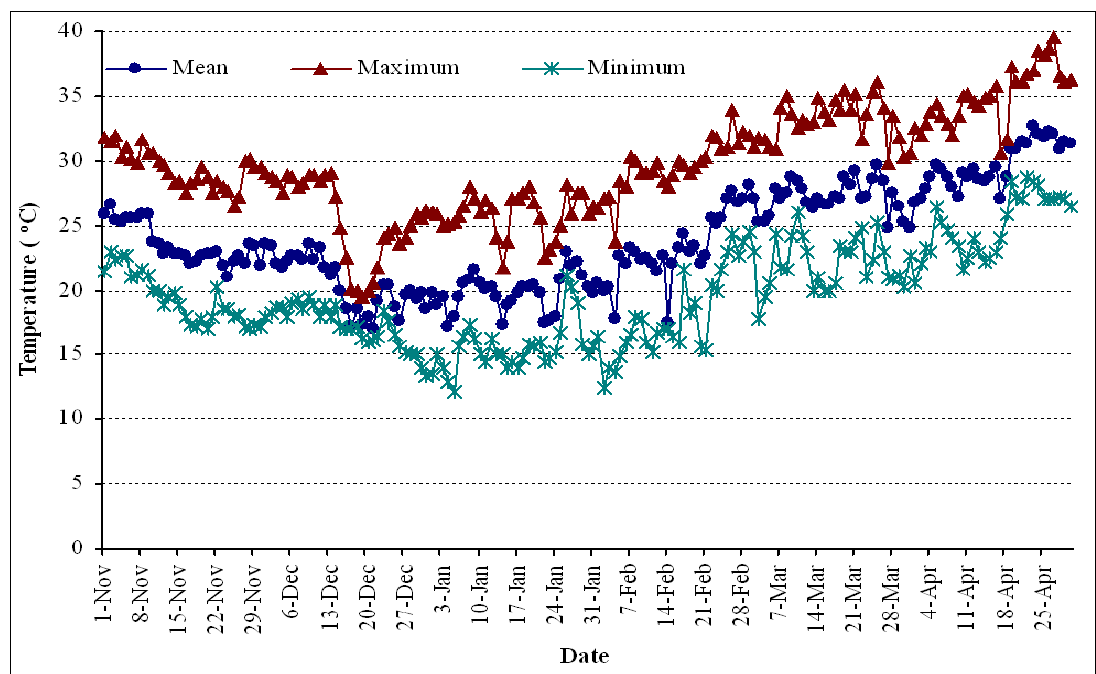
Fig. 1. Maximum, minimum and mean temperature during the experimental